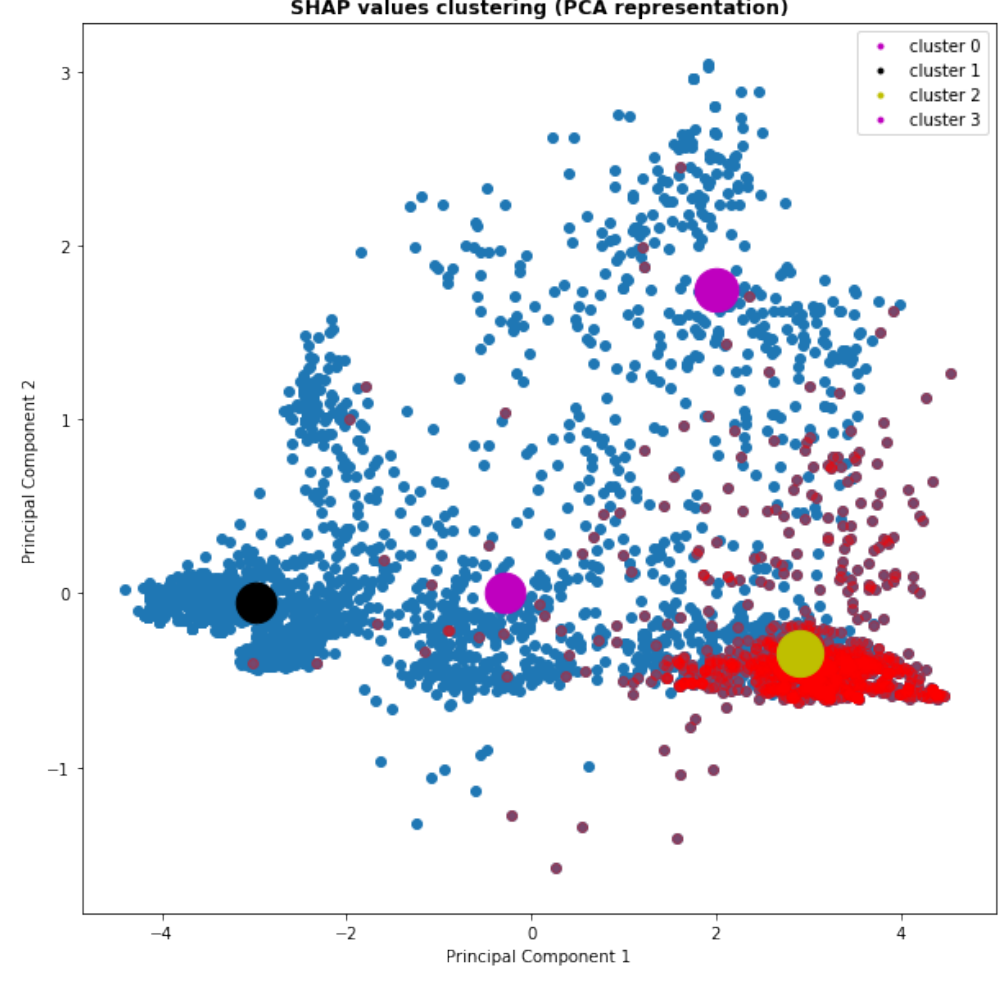
Figure 3. Clustering of Shapley